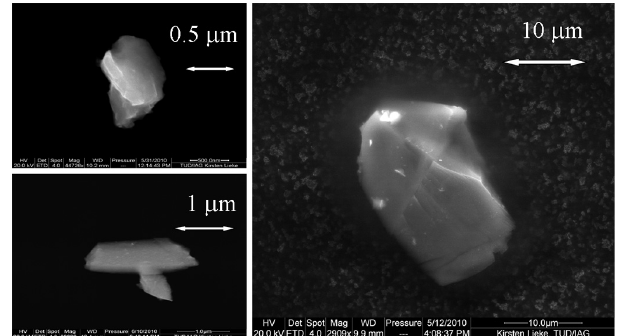
Fig. 4. Typical volcanic ash particles from the plume penetration over the North Atlantic on 2 May 2010. Left: sampled inside the fuselage, right: sampled outside. Particle sizes 0.7, 2, and 20µm.